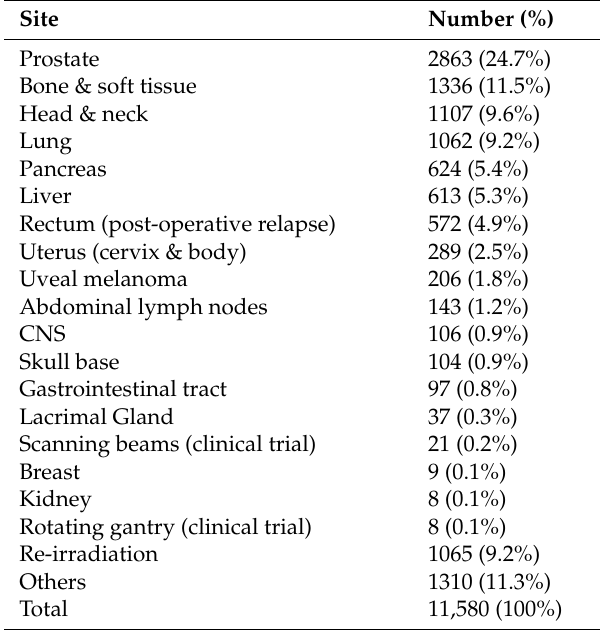
Table 2. Number of patients per cancer site treated with carbon ions at the National Institute of Radiological Sciences between June 1994 and July